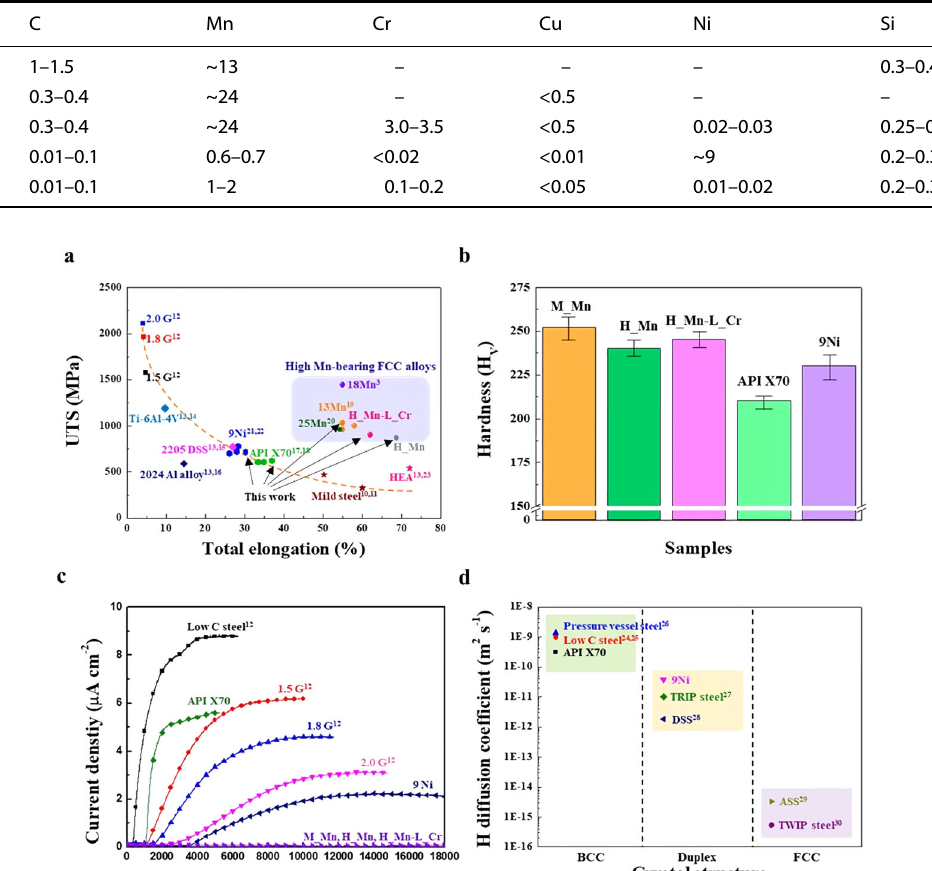
Fig. 1 Mechanical properties and H-permeation behaviors. a Chart for UTS-elongation of various ferrous alloys (mild steels (0.17C 10 /0.18C 11 ), 1.5 G (0.2 – 0.3C), 1.8 G (0.3 – 0.4C), and 2.0 G (0.4 – 0.5C) post heat-treated steels 12 , Ti-6Al-4V alloy 13,14 , 2205 duplex stainless steel (0.03 C-22.42Cr- 6.2Ni-2.94Mo) 13,15 , 2024 Al alloy (alloy 2024-T351 plate) 13,16 , API X70 steels (0.06 C – 0.50(Ni + Cu + Cr) 17 /0.08 C – 0.138Cr 18 ), 13Mn-based steel (0.6C – 13Mn) 19 , 18Mn-based steel (0.6C – 18Mn) 3 , 25Mn-based steel (25Mn-0.4 C) 20 , 9Ni steels (0.05C – 9Ni 21 /0.11C – 9Ni 12 ), and high entropy alloy (20Co-20Cr-20Fe-20Mn-20Ni) 13,23 ). b Vickers hardness measurements of the tested samples (the error bars represent SDs of the mean values). c Electrochemical H-permeation behaviors of various ferrous alloys (samples in the current study and previously reported study (low C